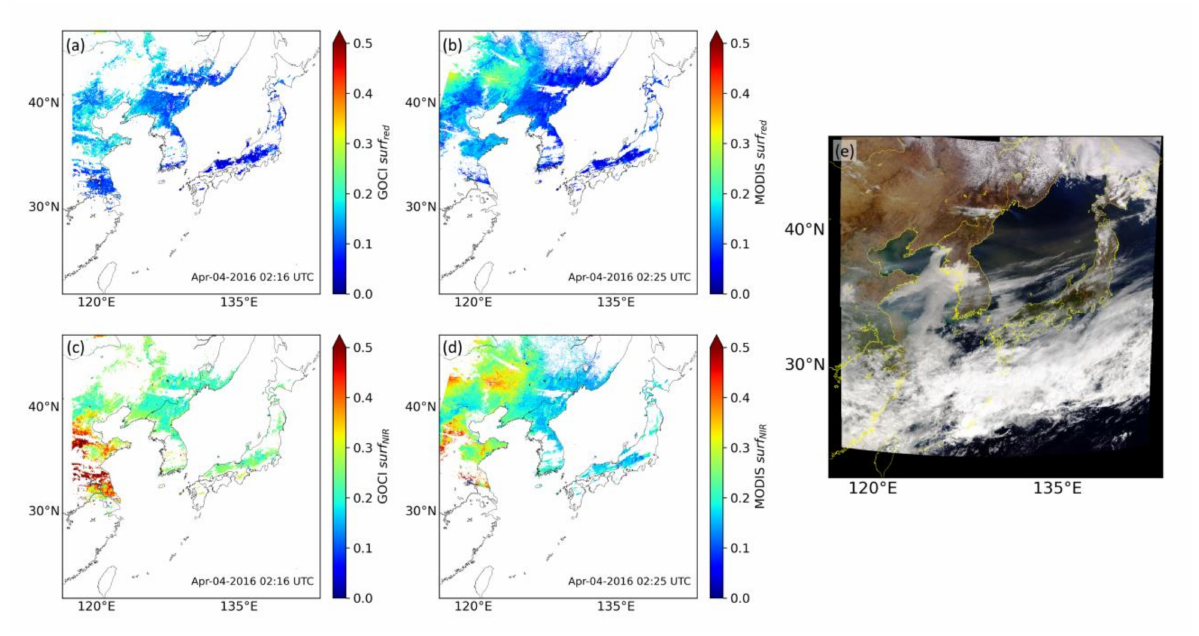
Figure 2. LSRs of red (680 nm) and NIR bands (865 nm) for GOCI ( a , c ) and MODIS ( b , d ); ( e ) GOCI RGB true-color image on 02:16 UTC, 9 April 2016. The times in ( a – d ) are observation times.